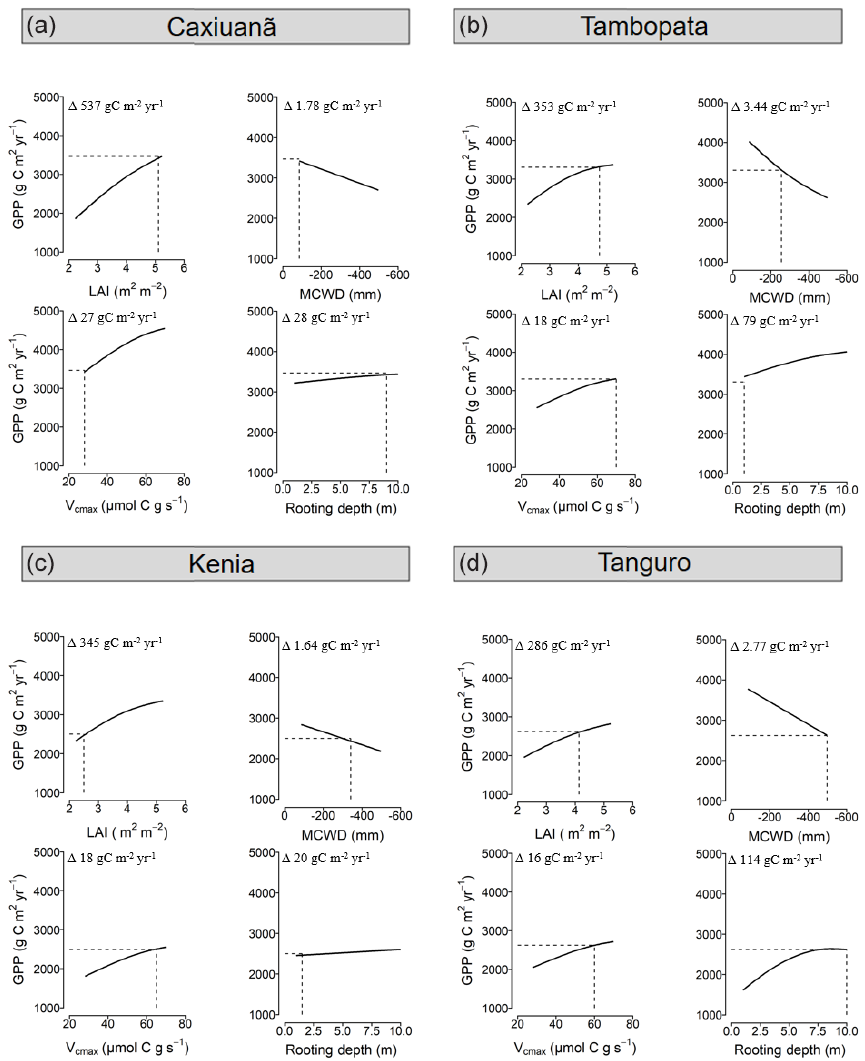
Figure 6. The sensitivity of GPP to model driver alternations in SPA at each location. Model drivers LAI, climate (characterised by MCWD), photosynthetic capacity (characterised by V cmax ) and rooting depth, derived from field observations, were alternated individually at each plot with that of all other plots and the resultant GPP retrieved. Solid lines represent SPA-simulated GPP under the named driver alternations, and the dashed line represents the simulated value under observed conditions. SPA GPP estimates presented are location averages. Climate and LAI were input to the model as time series. Photosynthetic capacity and rooting depth were fixed values. Plots are ordered to reflect soil moisture stress which increases from Caxiuanã to Tambopata to Kenia and to Tanguro. The range in GPP estimates under each set of driver alternations for each location is presented (i.e. (cid:49)